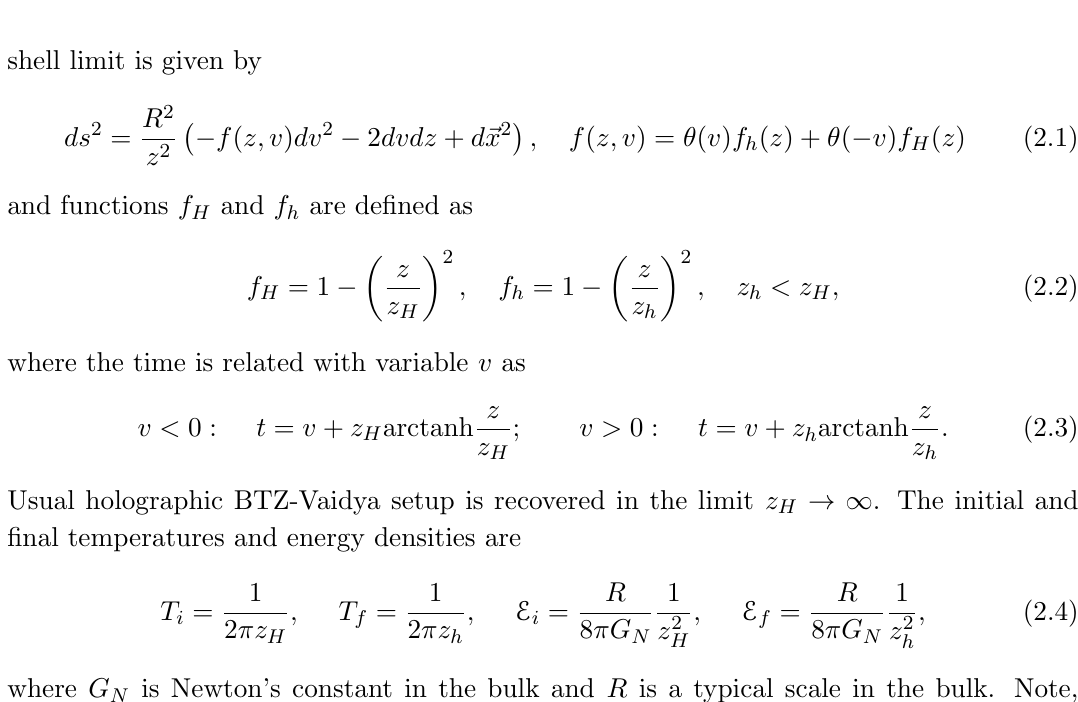
Figure 1 . Penrose diagrams for double-BTZ-Vaidya geometry de(cid:12)ned by (2.1) and (2.2). The left plot corresponds to z H = 0 (usual BTZ-Vaidya spacetime), the right plot corresponds to the case z H >